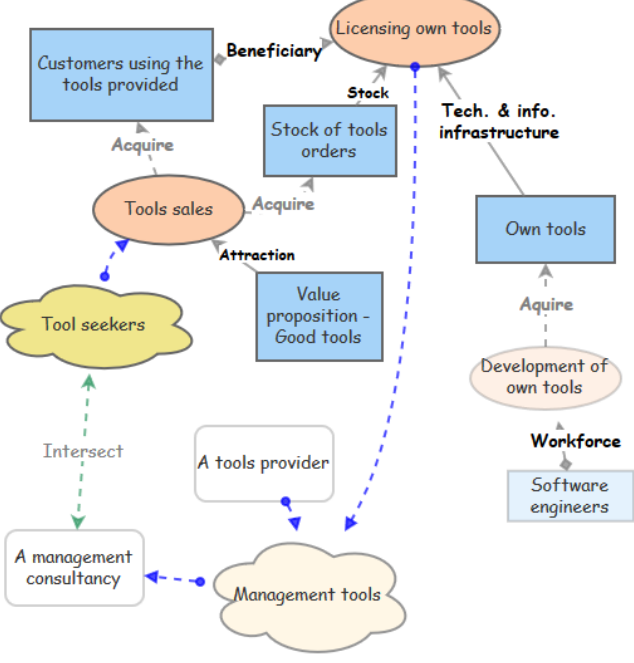
Figure 4. A new primary business process at